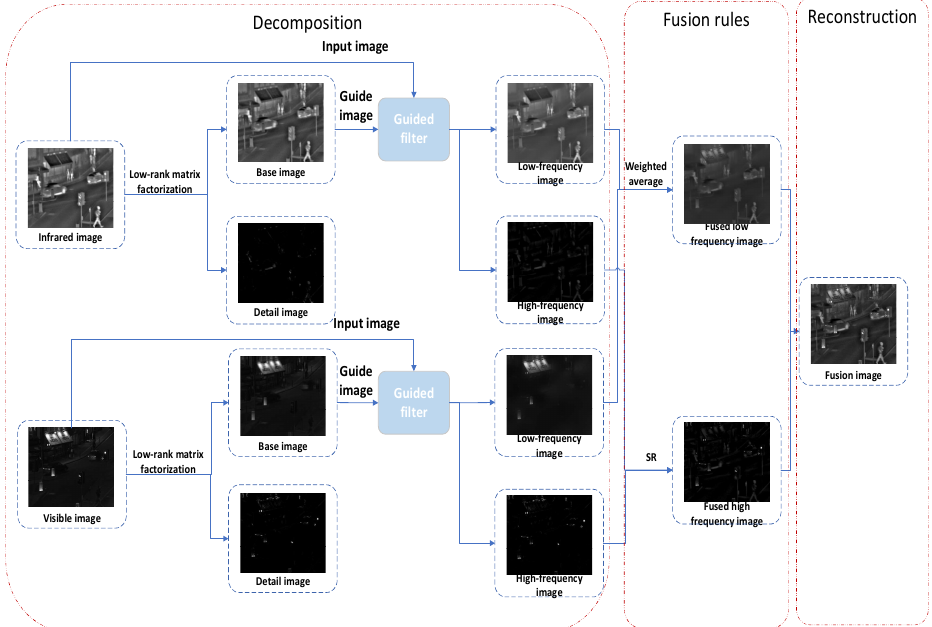
Figure 2. The framework of the fusion algorithm.